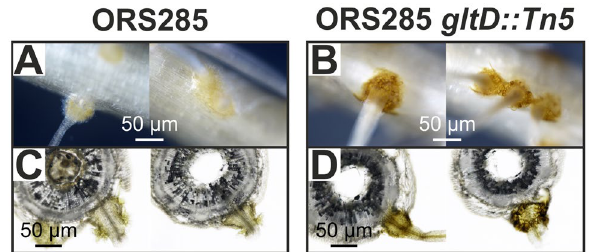
Figure 6. More intense browning of auxiliary root hairs on A. evenia plants inoculated with the Bradyrhizobium gltD::Tn5 mutant. Auxiliary root hairs of A. evenia plants inoculated with the ( A ) wild-type and ( B ) Bradyrhizobium gltD::Tn5 mutant strain at 5 dpi. 200 µM coupes of root segments at 5 dpi to visualize the auxiliary root hairs of A. evenia plants inoculated with the ( C ) wild-type and ( D ) Bradyrhizobium gltD::Tn5 mutant